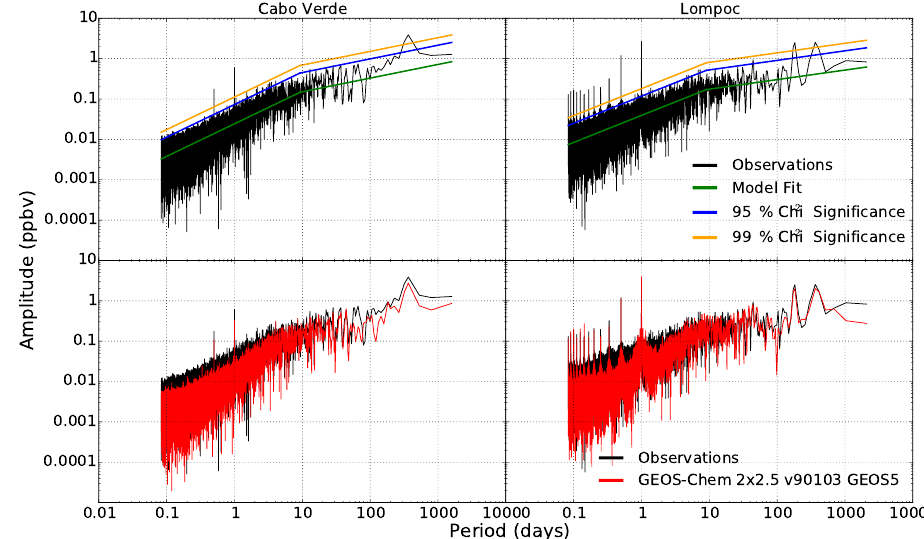
Figure 2. Lomb–Scargle periodogram spectra for surface O 3 at Cabo Verde (16.51 ◦ N, 24.52 ◦ W) and Lompoc (34.73 ◦ N, 120.43 ◦ W), between 2006 and 2012. The upper panels shows the observed data spectra together with chi-squared false-alarm levels for significant periodicity based on linear piecewise fits to the spectra. The lower panels compare the spectra of the observations (black) and the GEOS- Chem model (red).